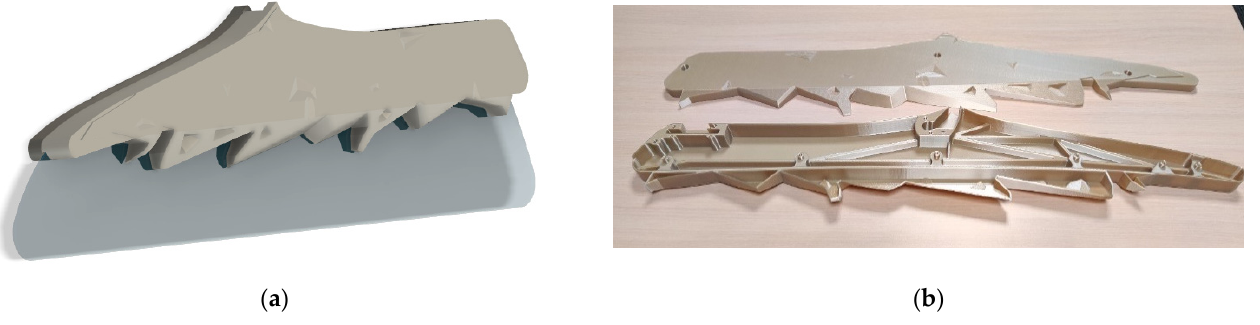
Figure 8. 3D design model of the class-divider part ( a ) and a real-life example of a 3D-printed class divider (two parts) with the modifications to pass the applied concentrated loads and design appearance of mountains ( b ).